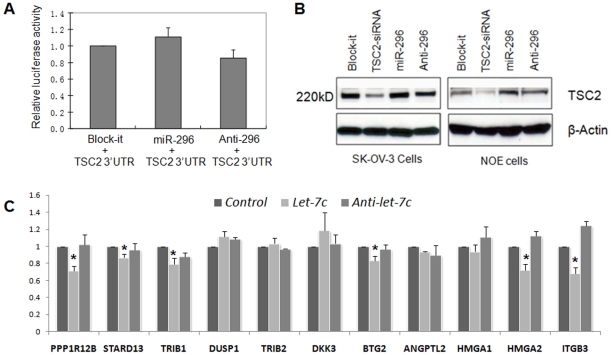
Analysis of the miR-296 predicted target gene TSC2 and 11 let-7 predicted target genes in vitro.
A Transient transfection analysis for luciferase reporter expression with TSC2 3′UTR in the presence and absence of miR-296. B Immunoblotting analysis of transient transfection analysis of miR-296 for TSC2 expression. TSC2 siRNA was used as a positive control antagonizing TSC2 expression. Block-iT = nonfucntional small RNA control. β-Actin was used as protein loading control. C Relative expression of let-7 predicted target genes (listed above) (y-axis) in transient transfection of nonfunctional small RNA (Block-iT (Controls), let-7c mimic and let-7 inhibitor (Anti-let-7). The relative expression levels were obtained in three cell lines of immortalized ULM cell line (ULM-3401), leiomyosarcoma cell lines (LMS-1, UT-1) (see Methods). T-bars indicate standard error of measurement. * = p value<0.05.